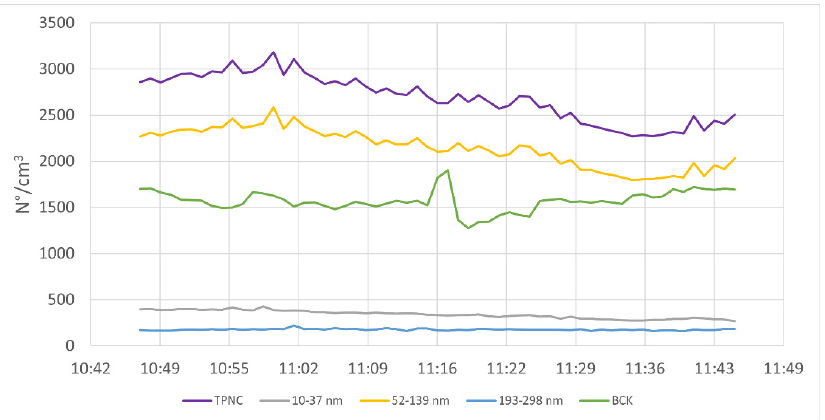
Figure 5. TPNC trends and the main particle size classes for O4–removing and cleaning of the final product and the recovery of unused powder by manually dragging the powder into the perforated grill around the building plate.